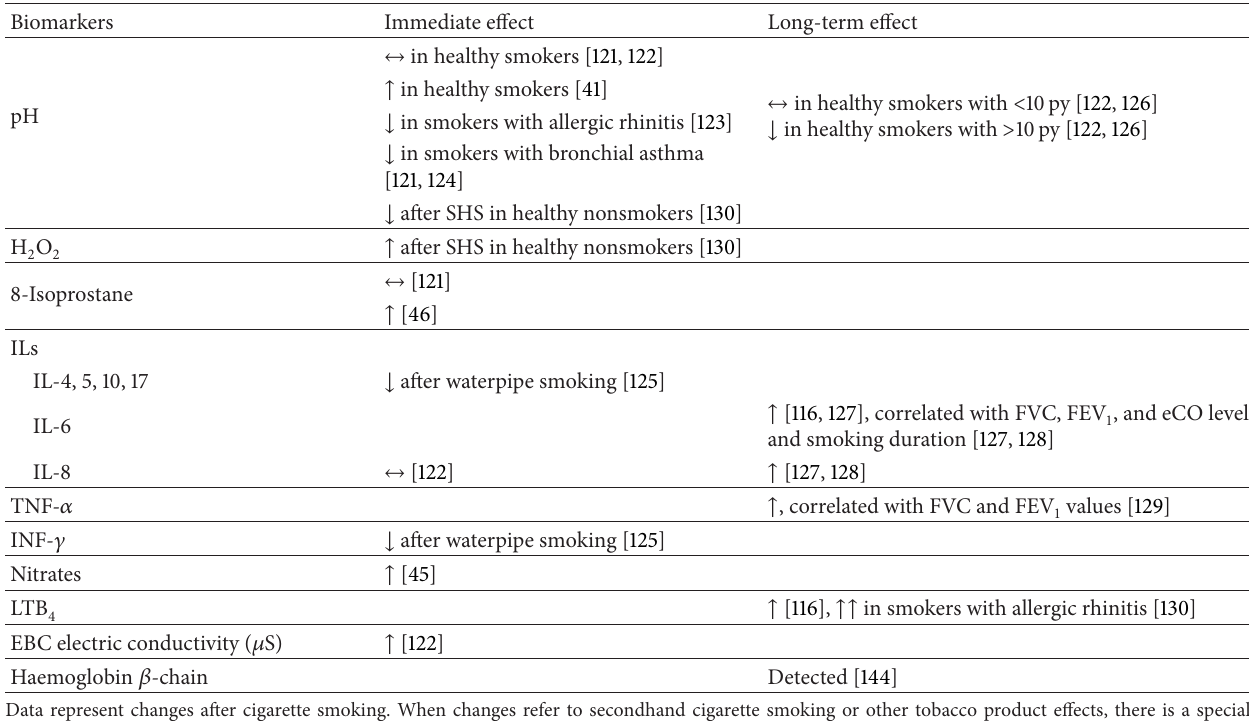
Table 2: Short and long-term effects of tobacco smoking on exhaled breath